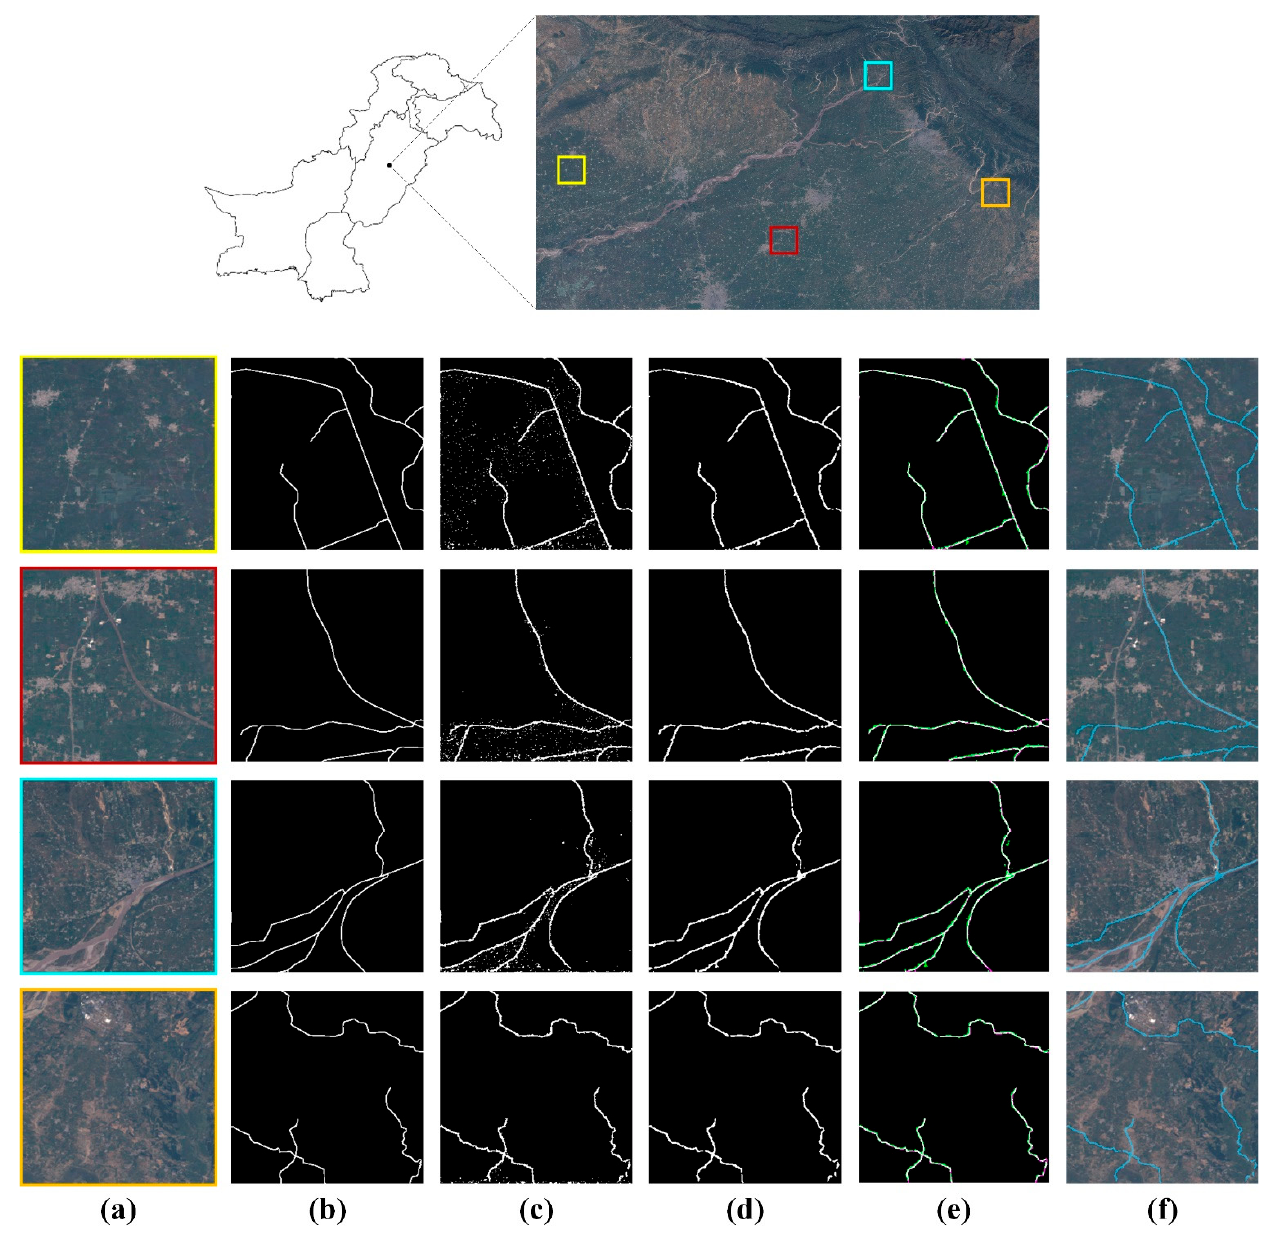
Figure 7. Qualitative water channel segmentation results: ( a ) raw input patches, ( b ) ground-truth pixels, ( c ) AUnet segmented labels containing noisy and stray pixels, ( d ) postprocessed images to remove noisy pixels, and ( e ) overlapped ground-truth and postprocessed pixels. Magenta depicts the undersegmented (false negative) pixels, and green indicates the oversegmented (false positive) pixels, ( f ) extracted and overlaid water channels on ( a ).